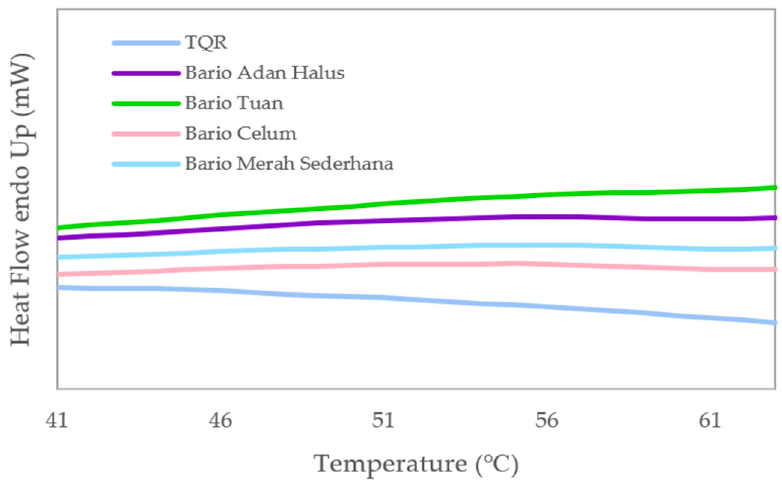
Figure 3. Retrogradation curve of rice flour samples for TQR, Bario Adan Halus, Bario Tuan, Bario Celum, and Bario Merah Sederhana.